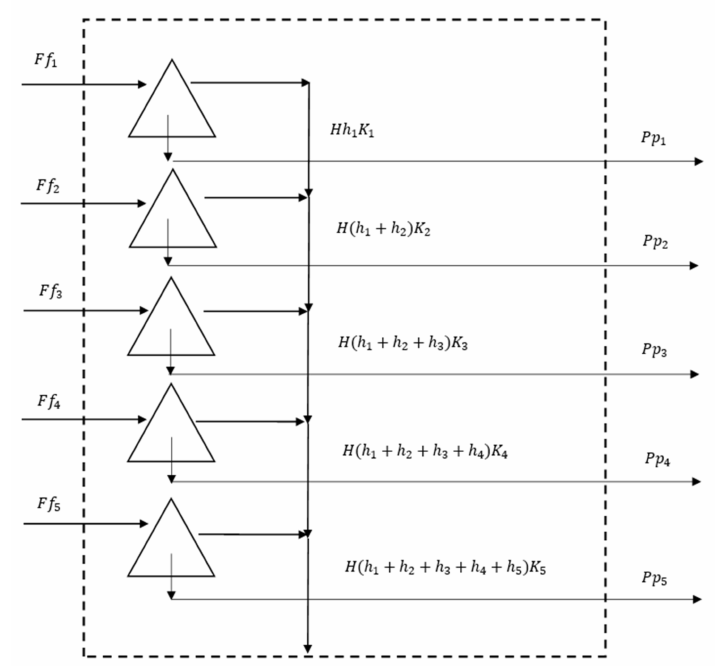
Figure 2. The simple model. The model depicts a perfectly mixed mill region, represented by the dotted line, with each size range within the region represented as a triangle. The arrows represent the contributions from a feed stream and to a product